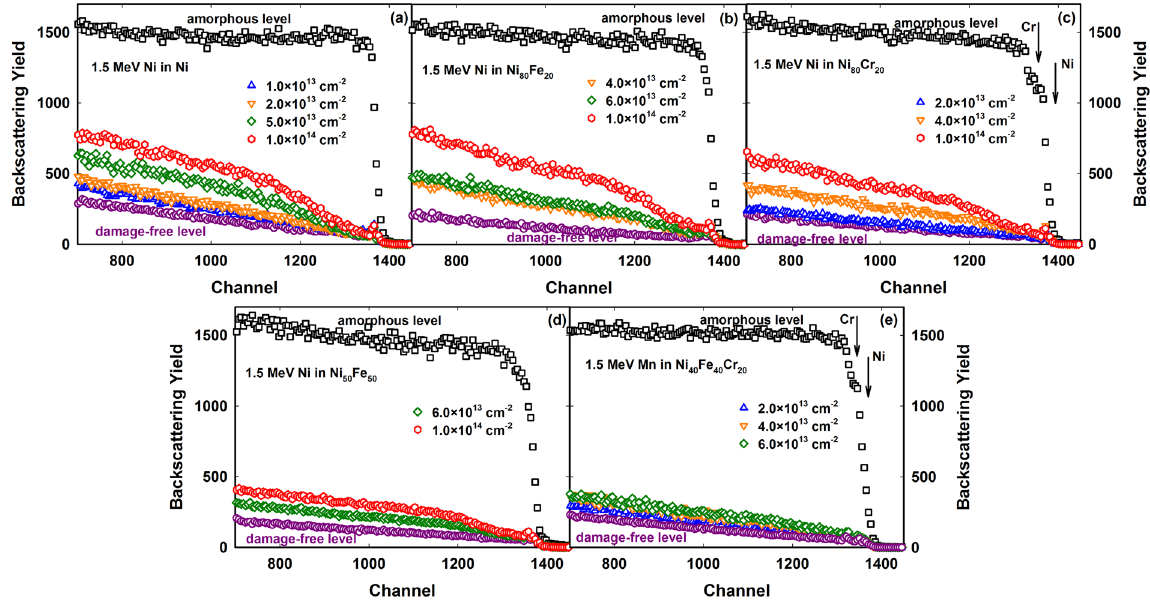
Figure 1. RBS spectra of the irradiated alloys. Spectra recorded from ( a ) Ni, ( b ) Ni 80 Fe 20 , ( c ) Ni 80 Cr 20 and ( d ) Ni 50 Fe 50 single crystals irradiated with 1.5 MeV Ni ions, and ( e ) Ni 40 Fe 40 Cr 20 irradiated with 1.5 MeV Mn ions, at various ion fluences. Both virgin and random spectra are included to indicate the damage-free level before irradiation and the fully amorphous (or random) level, where no crystallinity exists. The higher backscattering yield suggests more irradiation-induced damage. For visual clarity, only every five data points are